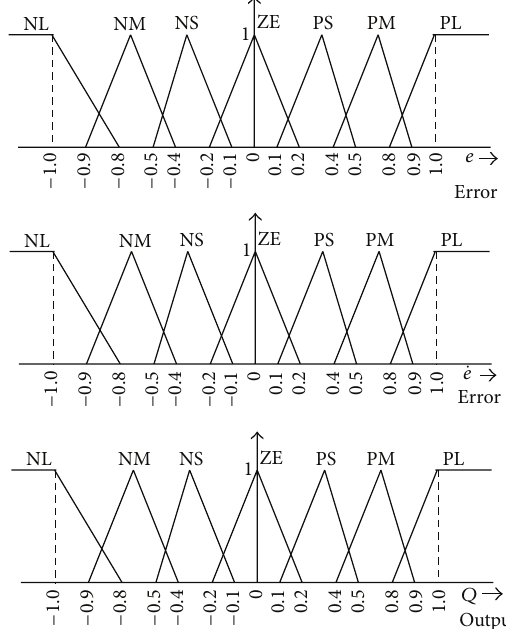
Figure 4: Membership functions of 𝑒 , ̇𝑒 , and 𝑄